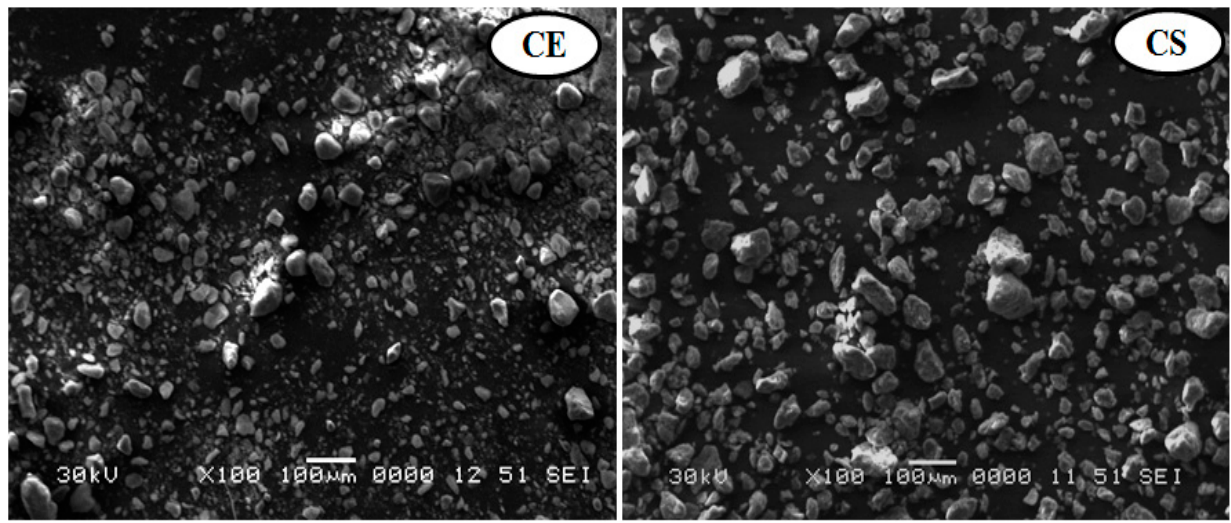
Figure 1. SEM images of Egyptian nanoclay (CE) at 0.2 μ m and standard nanoclay (CS) at 0.5 μ m.